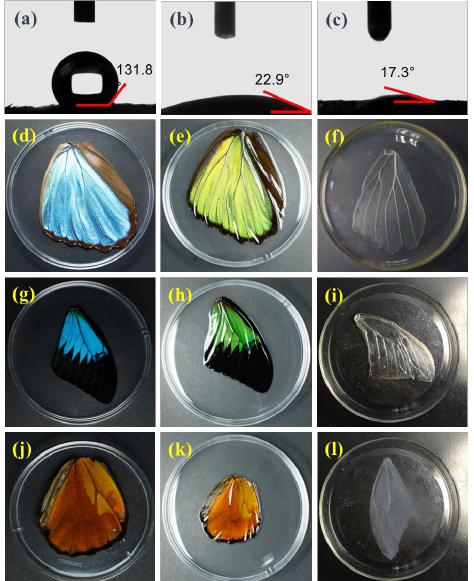
Figure 3. Treatment of butterfly wings. ( a – c ) Water contact angle on the wing surface of the M. menelaus butterfly wing ( a ) before and ( b ) after plasma treatment, and ( c ) after HCl/NaOH treatment. ( d – f ) Images of a M. menelaus wing ( d ) before and ( e ) after hydrophilic treatment , and ( f ) after HCl/NaOH treatment. ( g – i ) Images of a P. u. telegonus wing ( g ) before and ( h ) after hydrophilic treatment , and ( i ) after HCl/NaOH treatment. ( j – l ) Images of O. c. lydius wings ( j ) before and ( k ) after hydrophilic treatment , and ( l ) after HCl/NaOH treatment.